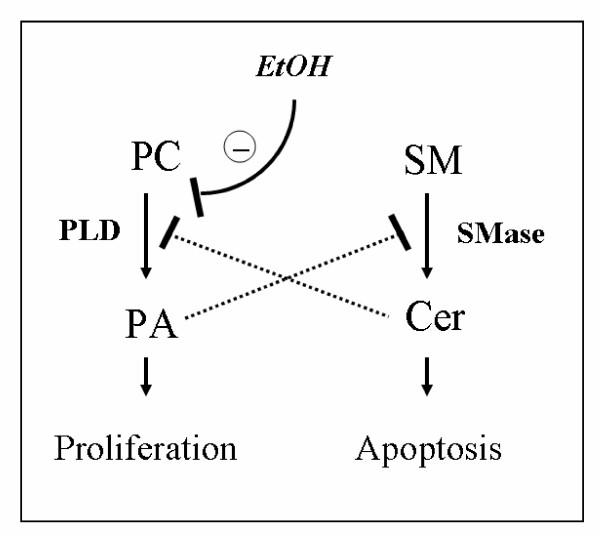
Hypothetical cross-talk between phospholipase D and sphingomyelin pathways in astrocytes, and effect of ethanol. Phosphatidic acid (PA), the product of phosphatidylcholine (PC) hydrolysis by phospholipase D (PLD), inhibits hydrolysis of sphingomyelin (SM) by sphingomyelinase (SMase). Vice versa, ceramide (Cer), the product of SM hydrolysis by SMase, inhibits activation of PLD. Ethanol induces apoptosis by disrupting the mitogenic PLD signaling pathway thereby decreasing the PA:Cer ratio and disinhibiting the pro-apoptotic SMase pathway.